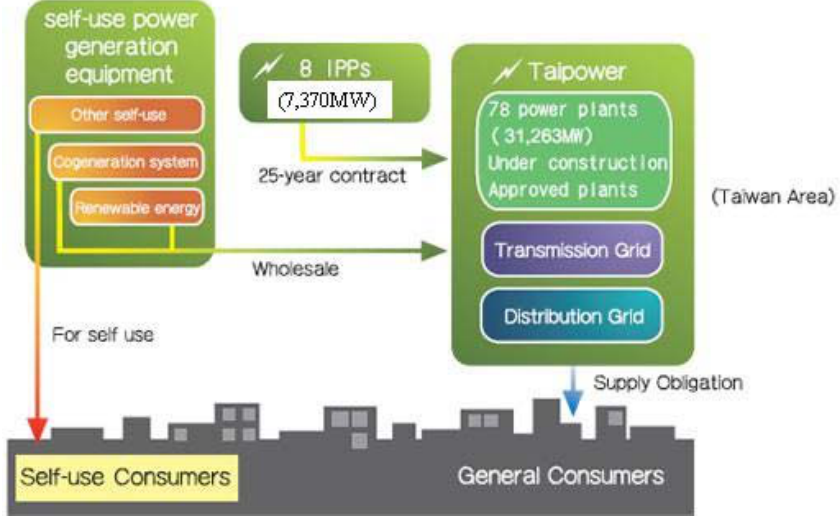
Figure 5. The current structure of power market in Taiwan